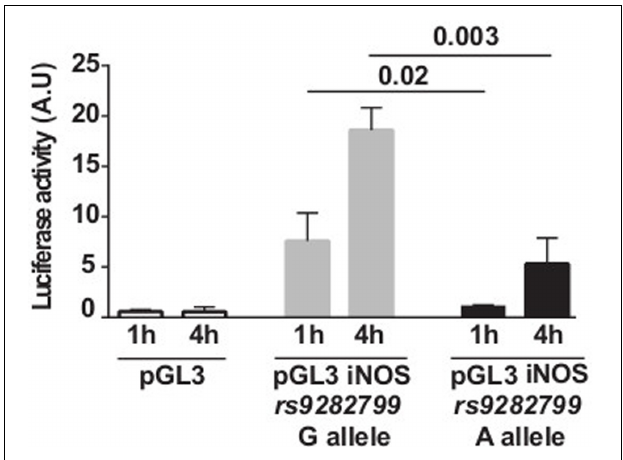
FIGURE 2 | Functional impact of iNOS rs9282799 polymorphism on promoter activity. Transcriptional activation of the iNOS promoter in response to PMA/ionomycin monitored by normalized luciferase activity of the empty (white), G containing (gray), and A containing (black) constructs transfected into the HeLa cell line. A.U., arbitrary